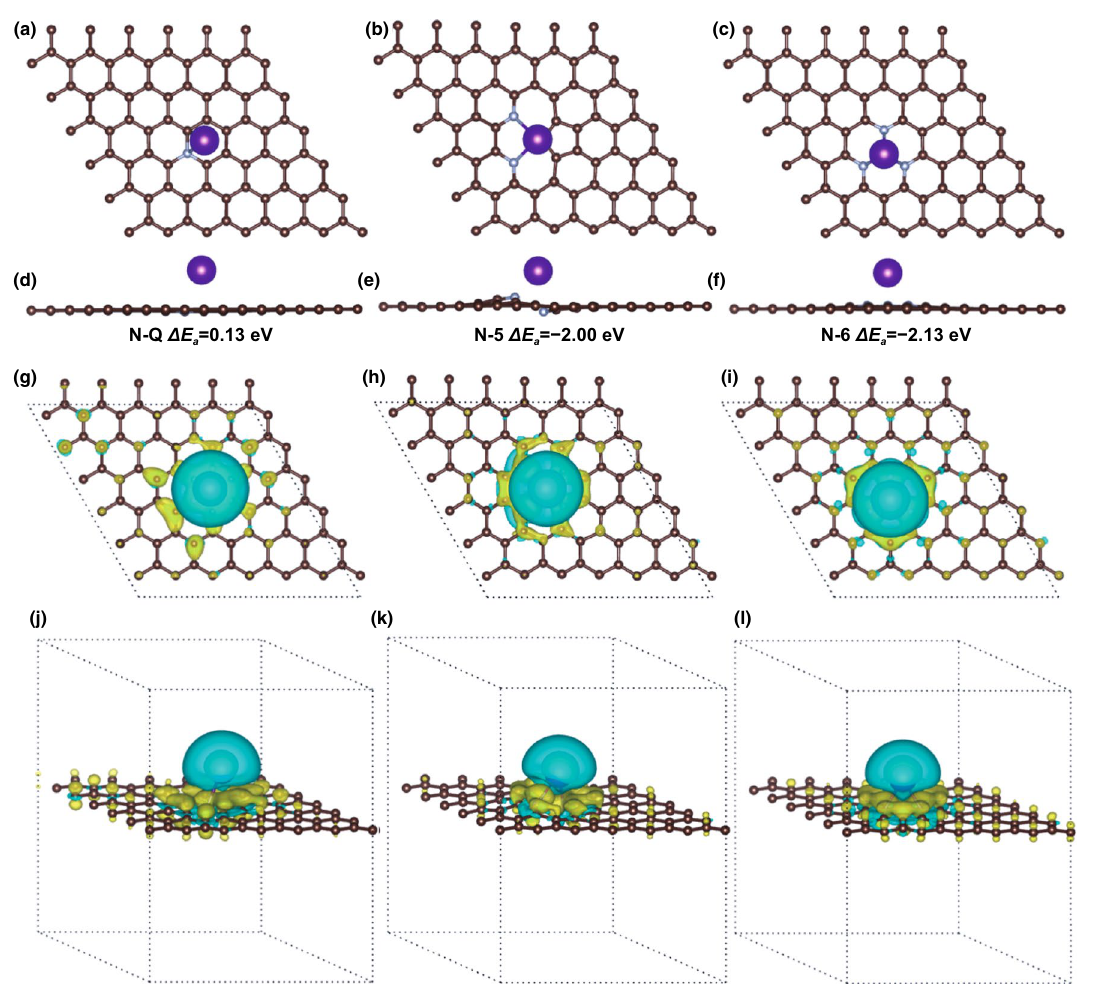
Fig. 5 K-adsorption theoretical simulations based on various N-doped structures. Top and side view of a K atom adsorbed in the N-Q ( a, d ), N-5 ( b, e ) and N-6 ( c, f ) structures and the corresponding adsorption energy. Top and side view of K-adsorption Electron density differences for the N-Q ( g, j ), N-5 ( h, k ) and N-6 ( i, l ) structures. Not that, C, N and K atoms are presented by brown, silver and purple balls, respectively. Increased and decreased electron densities are presented by yellow and blue regions,